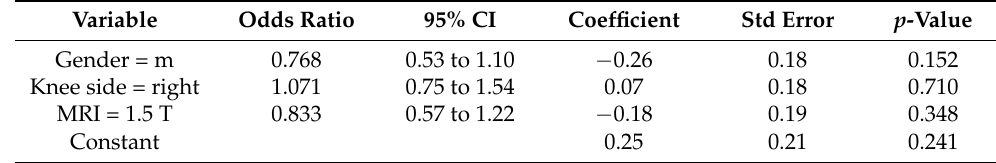
Table 4. Logistic regression of dichotomous variables for severe knee degeneration (Outerbridge >